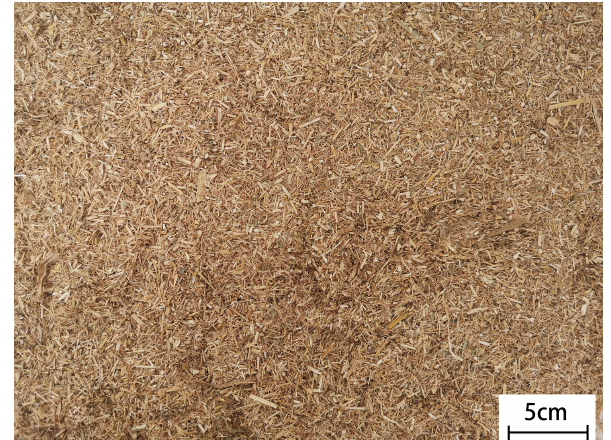
Figure 10. Crushing